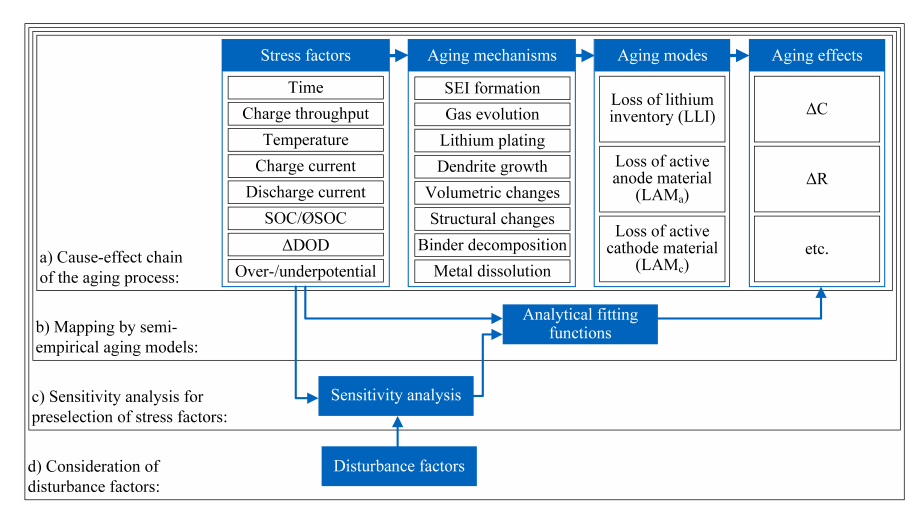
Figure 1. Overview of the cause–effect chain of aging and the concept of semi-empirical aging models: ( a ) Representation of the aging process by a schematic cause–effect chain including stress factors, aging mechanisms, modes and effects [8]. ( b ) For simulating, semi-empirical aging models map stress factors on aging effects. ( c ) For a high model quality, aging-relevant stress factors must be identified by performing a sensitivity analysis and further considered as model input parameters. ( d ) For robust sensitivity analyses, disturbance factors must be